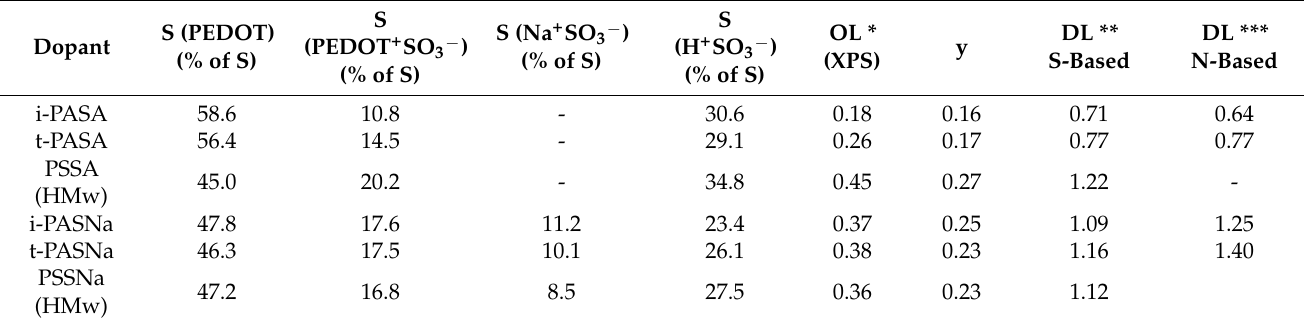
Table 3. Data for the atomic percent ratio of the sulfur species found in the PEDOT/polysulfonate specimens and calculated values for the Oxidation and Doping levels (OL and DL) and the electrochemical redox number y.